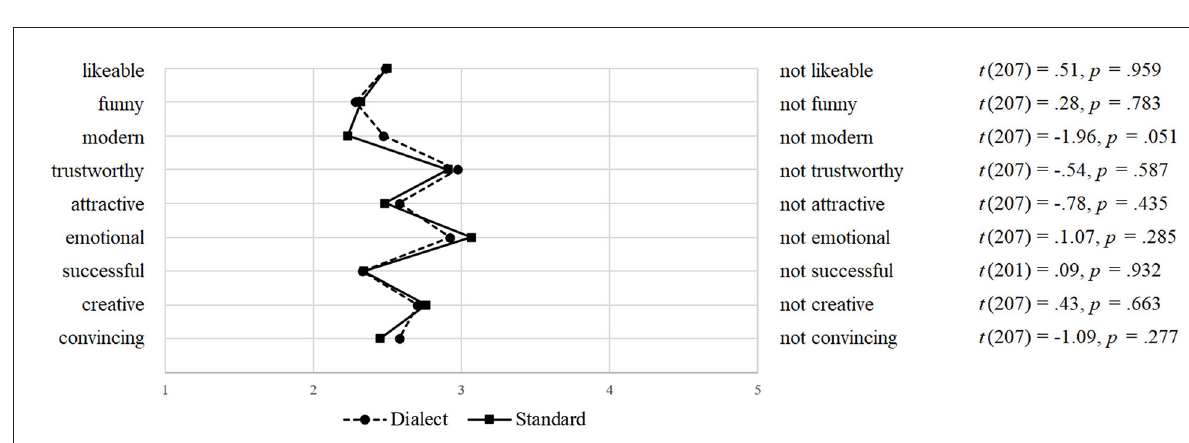
FIGURE4 Results for the overall perception of the presented image macros in study I.